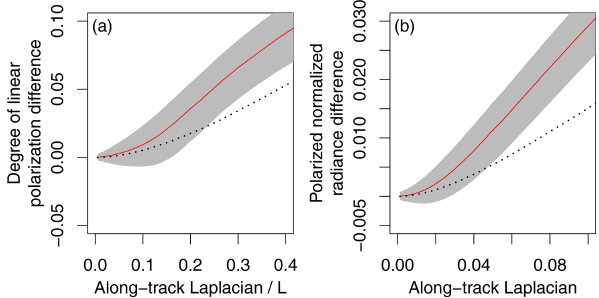
Figure 10. The same as Fig. 8 but without correlation in the cloud field simulation.